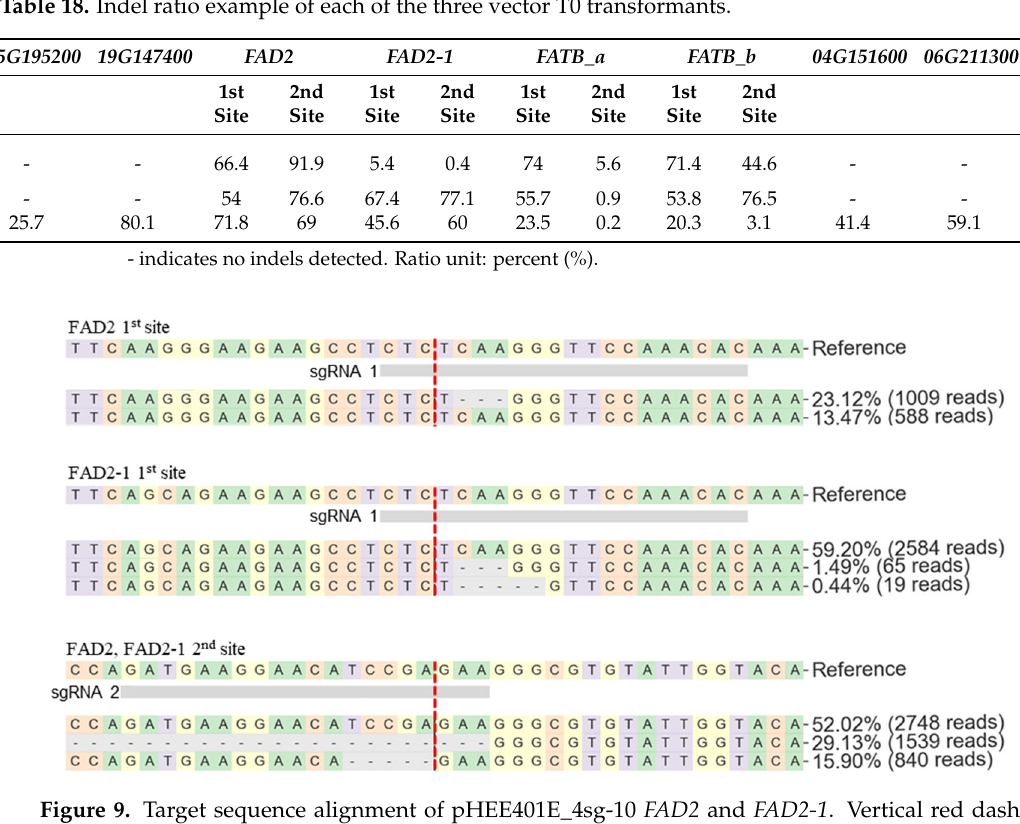
Table 18. Indel ratio example of each of the three vector T0 transformants.